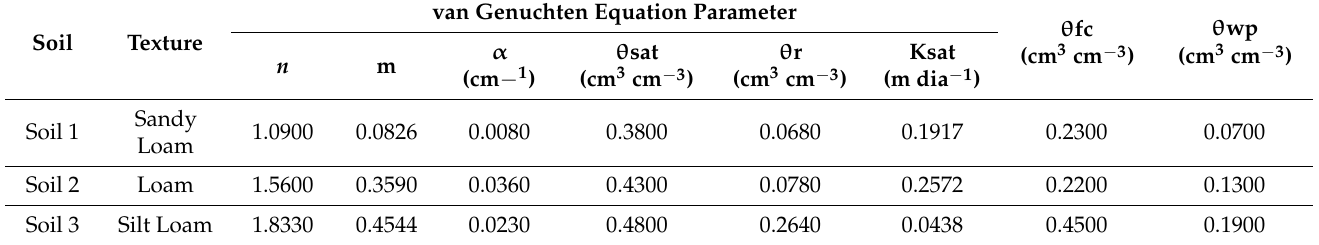
Table 3. Soil physical–water parameters used for simulations, texture, soil water retention equation adjustment parameters (n and m), soil volumetric moisture corresponding to saturation, residual, field capacity and wilt point ( θ sat, θ r, θ fc e θ wp), the inverse of the air entry suction ( α ) and saturated hydraulic conductivity